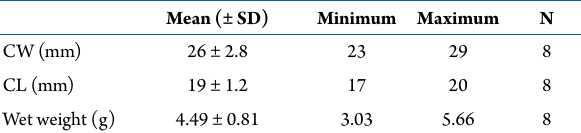
Table 1. Mean with standard deviation (± SD), minimum and maximum of carapace width (CW), carapace length (CL), and wet weight of crabs ( Ptychophallus tumimanus ) in the